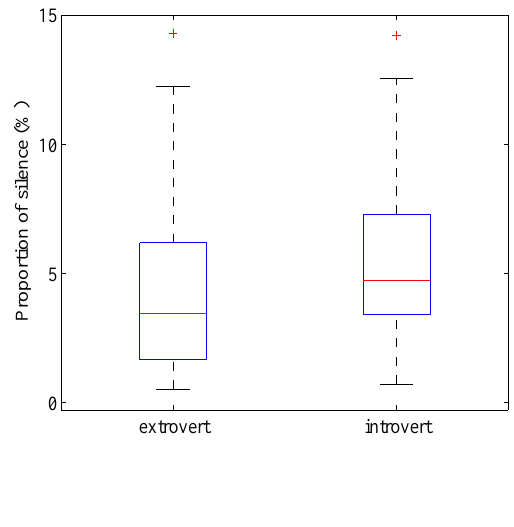
Fig. 2. Proportion of silent intervals in speech.(Source: findings from the preliminary experiments for this